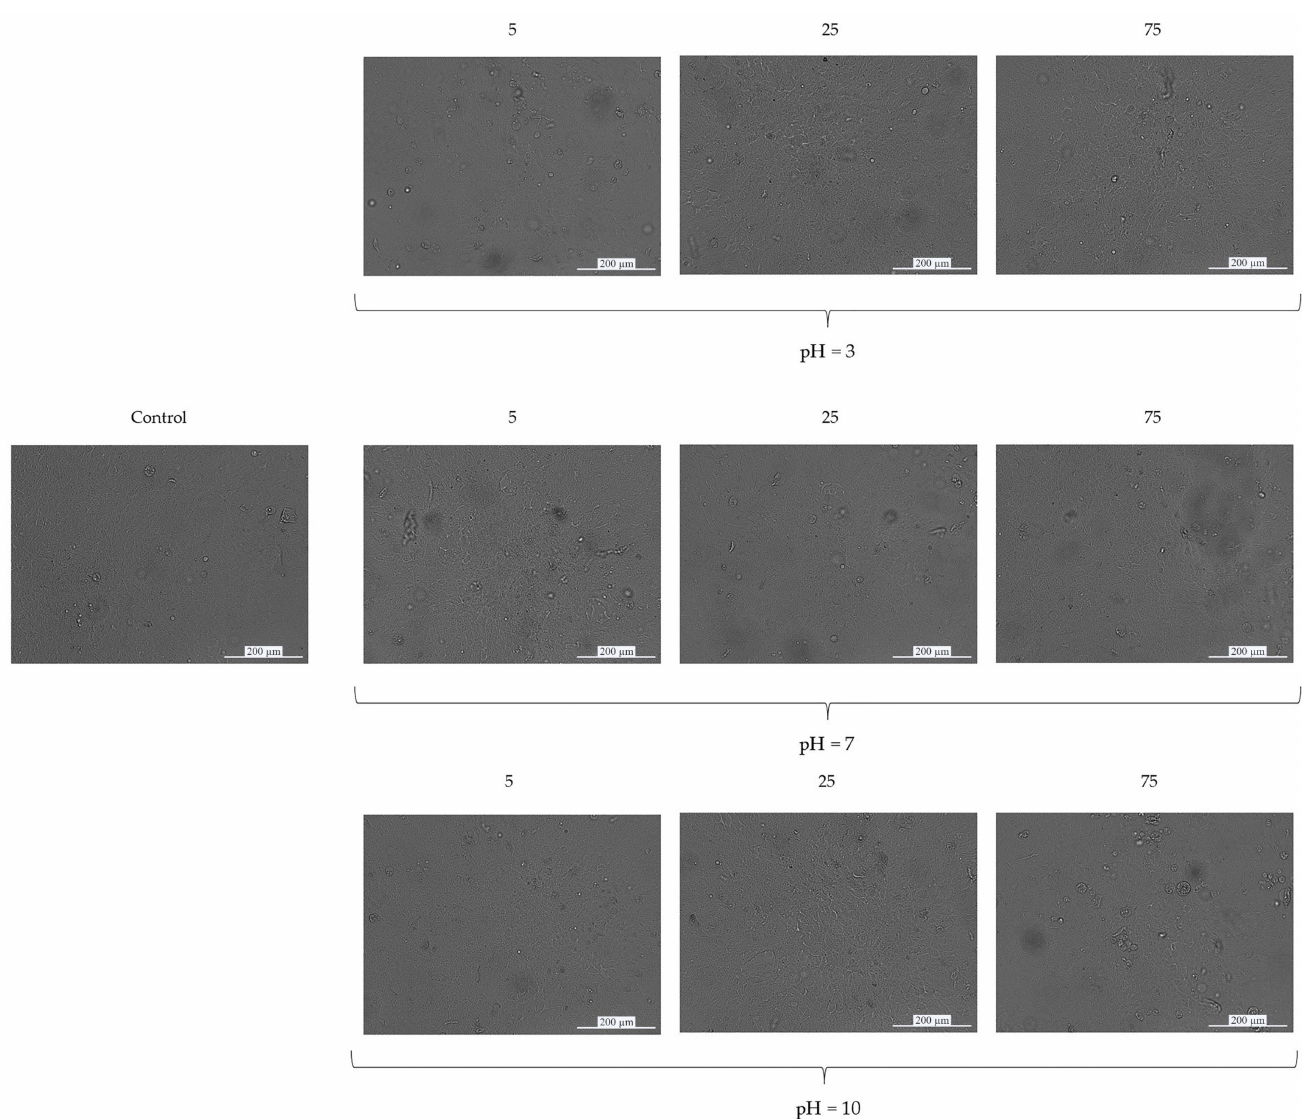
Figure 4. Morphological and shape changes produced by P2 (5, 25, and 75 µ g/mL) in Detroit-562 cells after 72 h of treatment. No changes were observed in the morphology of cells treated with P2, as their number, confluence, and shape were similar to those of control cells (unstimulated). The scale bars indicate 200 µ